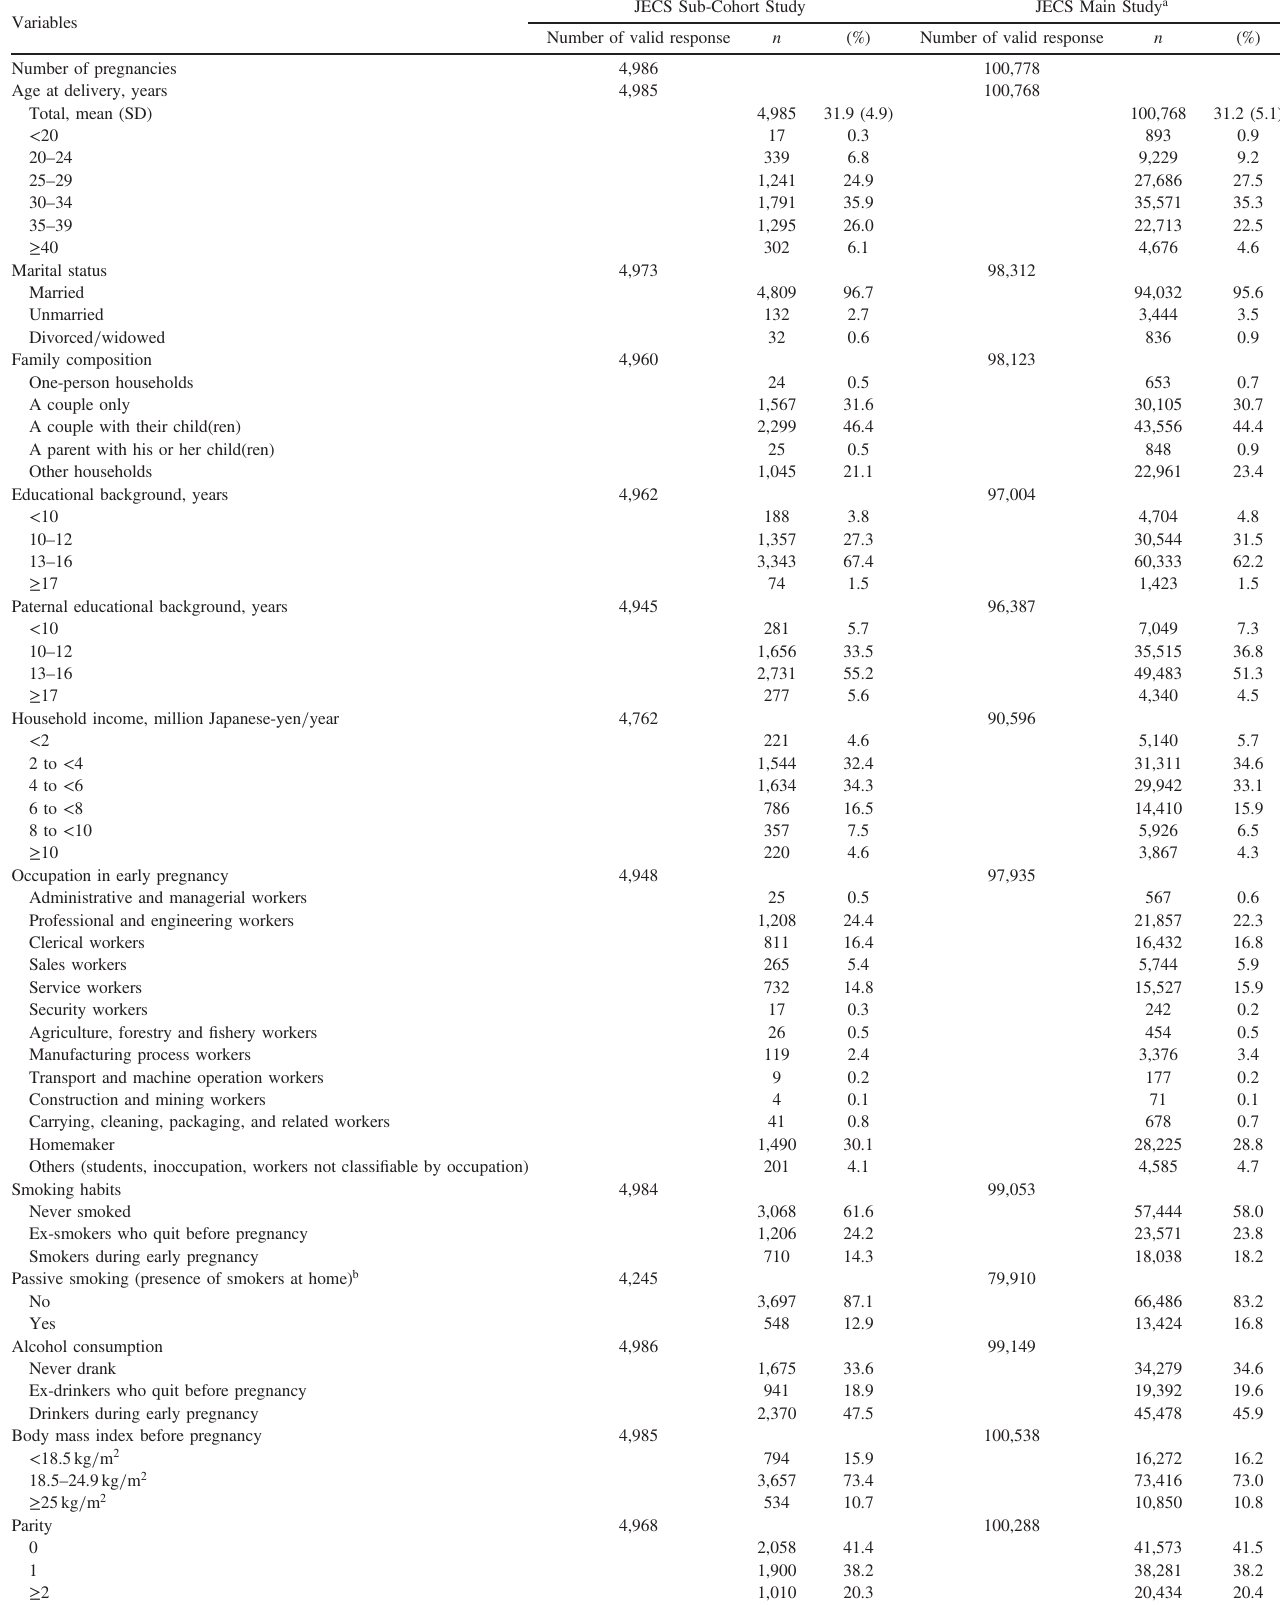
JECS Sub-Cohort Study JECS Main Study a Number of valid response n (%) Number of valid response n (%)